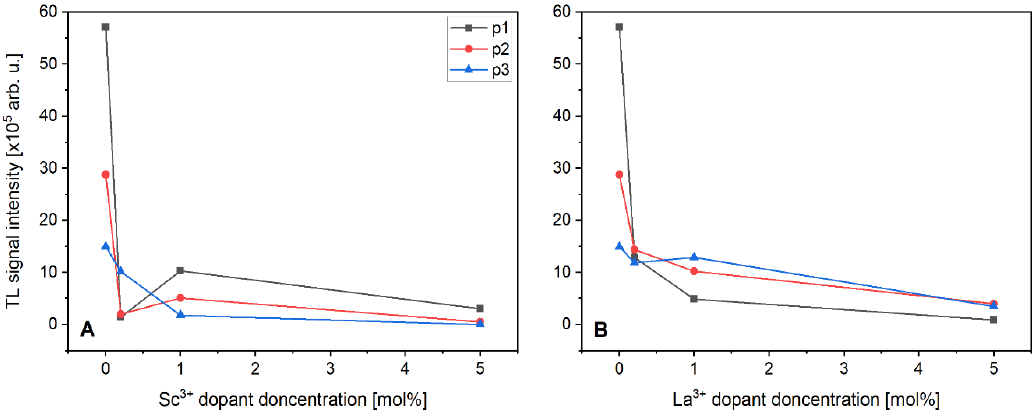
Figure 5. TL signal intensity dependence on the Sc 3+ ( A ) and La 3+ ( B ) dopant concentration for peaks p1, p2, and p3 as denoted in Figure 4.